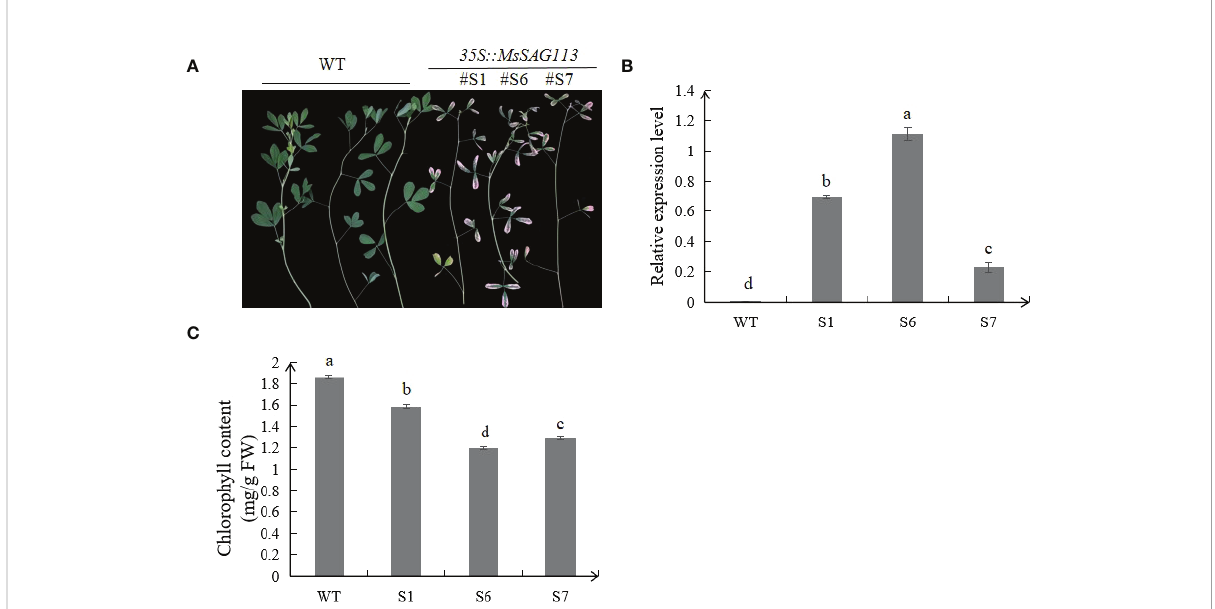
FIGURE 3 Phenotypes analysis of transgenic and WT alfalfa. Phenotype of three transgenic lines and WT alfalfa of 2 month-old (A) . Relative expression levels of MsSAG113 in transgenic and WT plants (B) . Chlorophyll contents of three transgenic and WT plants (C) . The values are means ± SD (n = 3). In graphs, bars with different lowercase letters indicate signi fi cant difference at